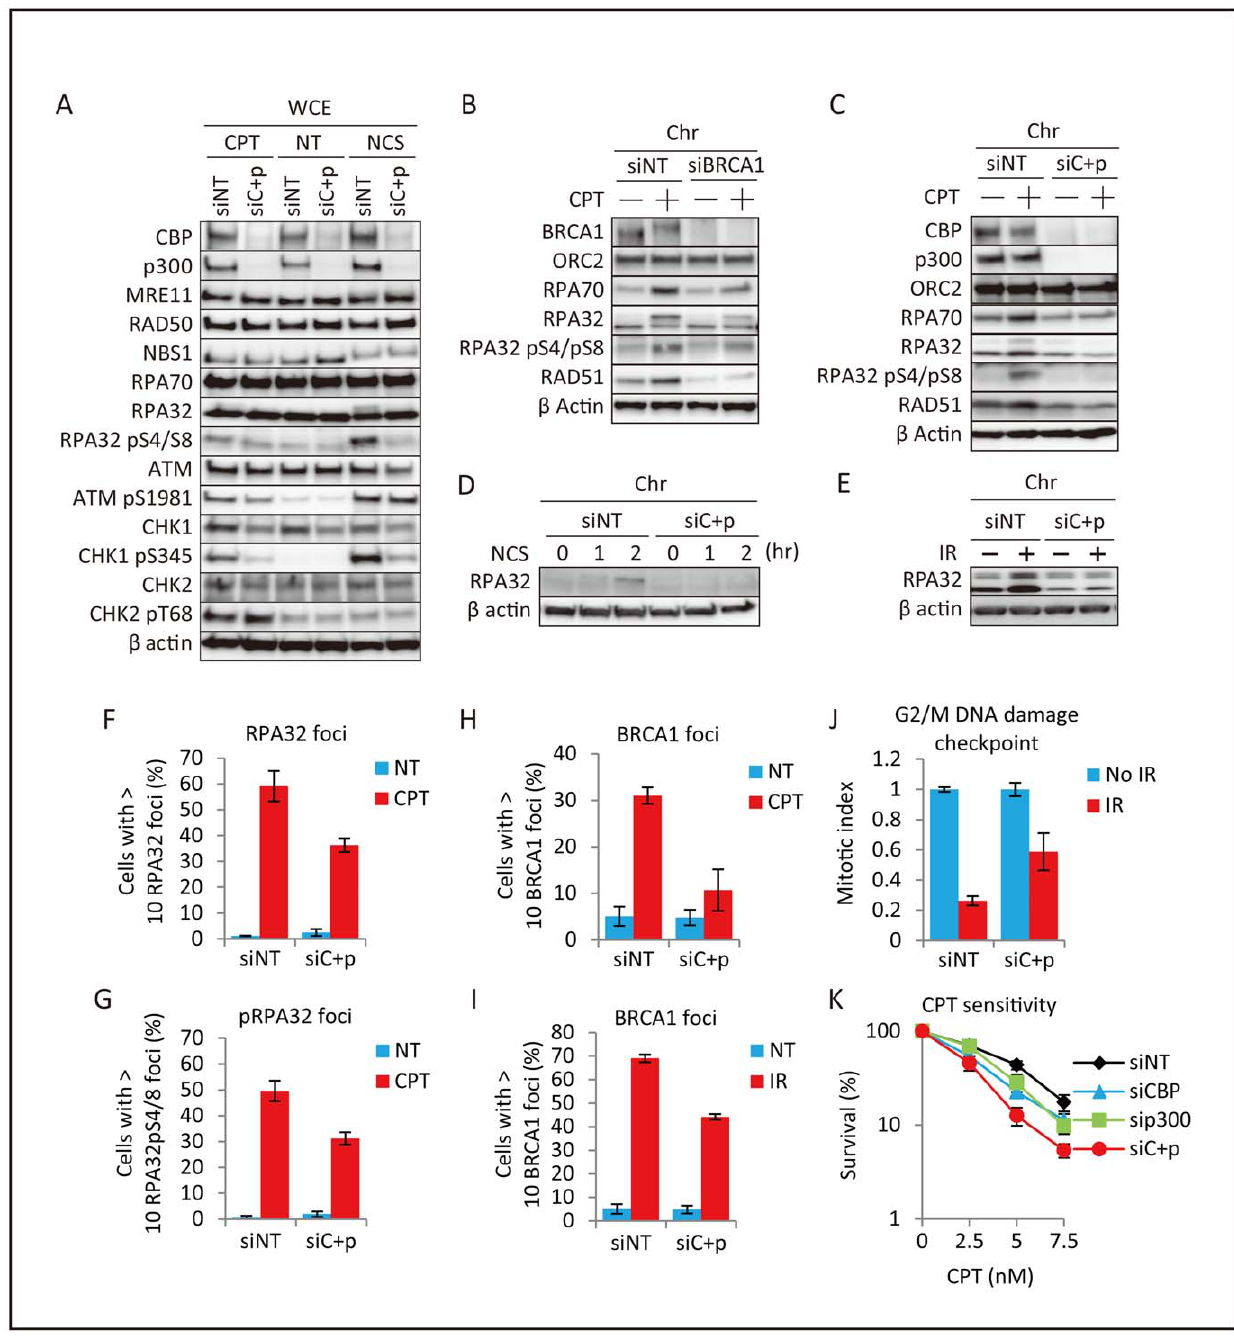
Figure 4. Impairment of RPA foci formation and the DNA damage checkpoint in CBP and p300 depleted cells. ( A ) Effects of CBP and p300 depletion on DSB-induced RPA and CHK1 activation. H1299 cells were pre-transfected with non-targeting (siNT) or CBP and p300 (siC + p) siRNA for 48 hr, and treated with DMSO (NT), 1 m M camptothecin (CPT), or 500 ng/ml neocarzinostatin (NCS) for 2 hr. Whole cell extracts were subjected to immunoblot analysis. ( B, C ) Decreased DSB-induced chromatin binding of RPA proteins. Chromatin enriched fractions from H1299 cells pre- transfected for 48 hr with non-targeting (siNT), BRCA1 (B), or CBP and p300 (siC + p) (C) siRNAs and treated with DMSO (NT) or 1 m M camptothecin (CPT) for 2 hr were subjected to immunoblot analysis. ( D, E ) Decreased DNA damage-induced chromatin binding of RPA proteins in H1299 cells. Chromatin enriched fractions from cells pre-transfected for 48 hr with non-targeting (siNT) or CBP + p300 (siC + p) siRNA were treated or not treated (NT) with (D) 500 ng/ml neocarzinostatin (NCS) for 1 or 2 hr, or (E) incubated for 3 hr after 50 Gy ionizing irradiation (IR) and subjected to immunoblot analysis. ( F, G ) Decreased DSB-induced RPA32 foci formation. H1299 cells were transfected with non-targeting (siNT) or CBP and p300 (siC + p) siRNA for 48 hr, treated with DMSO (NT) or 1 m M camptothecin (CPT) for 3 hr, and subjected to immunofluorescence analysis. The percentages of cells with RPA32 foci (F) or phosphorylated RPA32 (pS4/S8) foci (G) are shown. Data represent the mean 6 SD. ( H, I ) CPT- and IR-induced formation of BRCA1 foci. H1299 cells were transfected with non-targeting (siNT) or CBP and p300 (siC + p) siRNA for 48 hr, treated with 1 m M camptothecin (CPT) for 3 hr (H) or 10 Gy ionizing irradiation (IR) for 4 hr (I), and subjected to immunofluorescence analysis. The percentages of cells showing . 10 BRCA1 foci are shown. Data represent the mean 6 SD. ( J ) Suppression of the G2/M DNA damage checkpoint. H1299 cells were pre-transfected for with non-